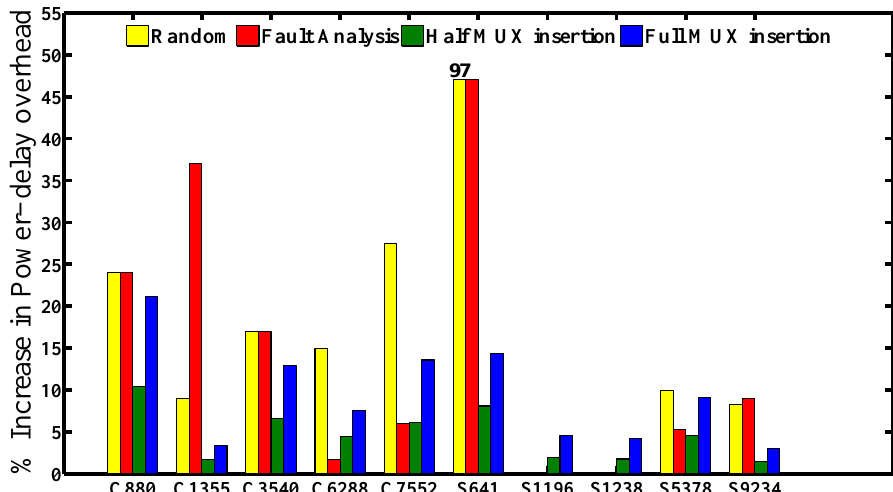
Figure 9. Comparing the power-delay overhead of random, fault analysis and full/half MUX insertions for logic